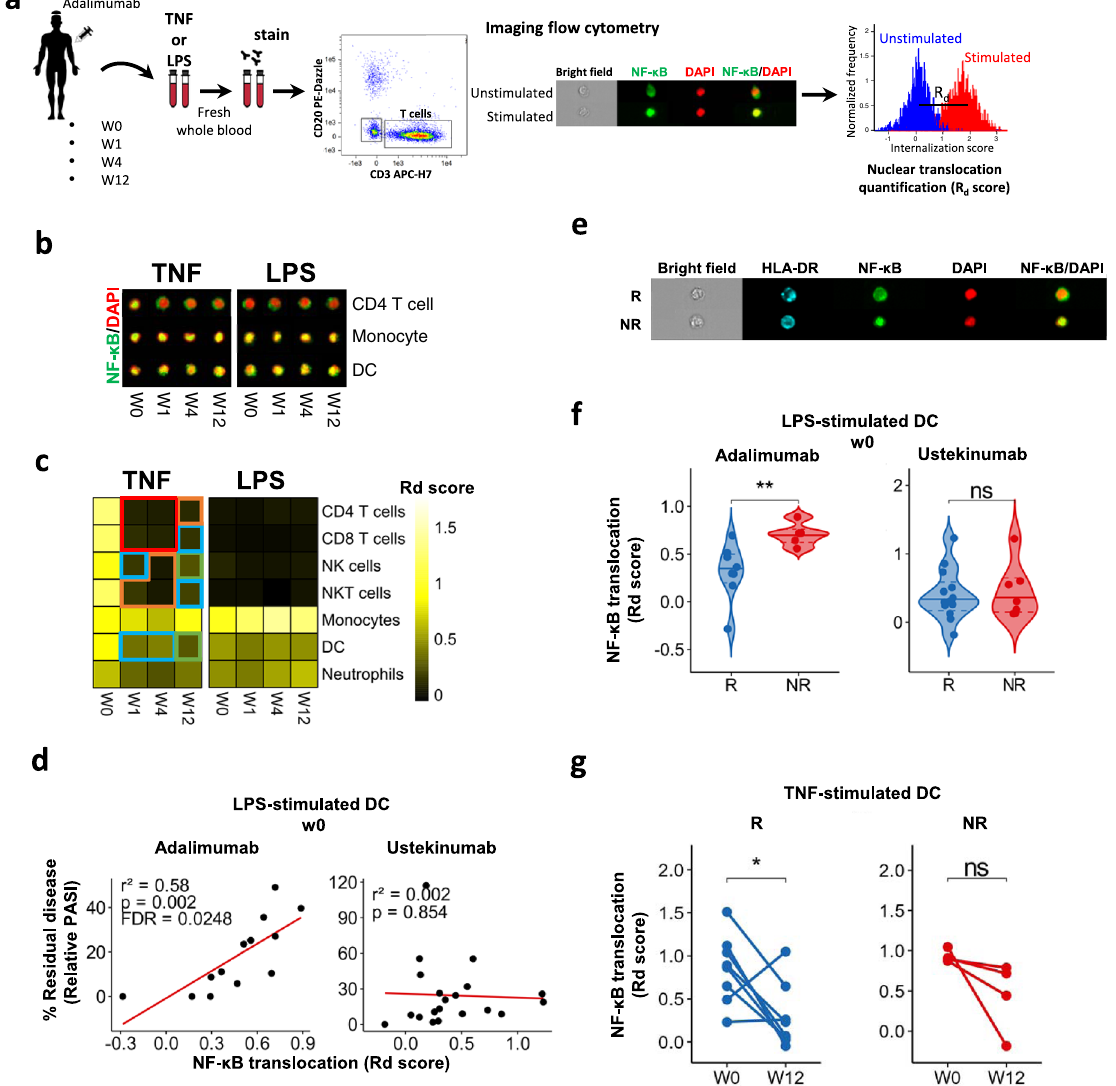
Fig. 1 LPS-induced NF- κ B translocation in DCs at baseline correlates with response to adalimumab. a Cartoon depicting the experimental work fl ow. Whole blood from psoriasis patients collected at baseline (week0, w0) and at w1, w4 and w12 after initiation of adalimumab therapy was stimulated with TNF, LPS or left unstimulated, stained with fl uorescent antibodies and NF- κ B nuclear translocation was measured in distinct cell populations identi fi ed by imaging fl ow cytometry, as shown in the representative images included in the cartoon. b Representative fl uorescent images of selected cell populations stained for NF- κ B (green) and nucleus (DAPI, red); their colocalization is shown in yellow. c Heatmap showing NF- κ B nuclear translocation measured as Rd score in immune cell populations ( n = 13 – 16). d Correlation analysis between NF- κ B translocation (measured as Rd score) at w0 and clinical response expressed as percentage of residual disease at w12 (measured as relative PASI, i.e. PASI at w12/PASI at w0 X 100) in LPS-stimulated dendritic cells (DCs) in PSORT adalimumab ( n = 13) and ustekinumab cohort ( n = 24). Each dot represents one patient. e Representative fl uorescent image of LPS-stimulated DCs at w0 from PASI75 adalimumab responder (R) and non-responder (NR). f Violin plot graphs of NF- κ B translocation in LPS-stimulated DCs at w0 for PASI75 adalimumab and ustekinumab responders (blue, adalimumab = 8; ustekinumab = 13) and non-responders (red, adalimumab = 5; ustekinumab = 7) ** p = 0.0062. g NF- κ B translocation in TNF-stimulated DCs at w0 and w12 in adalimumab PASI75 responders ( n = 8) and non- responders ( n = 4). Red frame: FDR < 0.0001, orange frame: FDR < 0.001, blue frame: FDR < 0.01, green frame: FDR < 0.05 compared to week (w) 0, test. * p = 0.039, Wilcoxon test followed by FDR ( c ), Wilcoxon ( g ) or Mann – Whitney U test ( f ). All tests are two-sided. Source data are provided as a Source Data fi NF- κ B translocation in DCs at baseline correlates with lack of NF- κ B translocation in psoriasis patients (Fig. 1b, c; Supple- response to adalimumab . Next, we investigated whether NF- κ B mentary Fig. 3c and Supplementary Data 2). Thus, we concluded that the free adalimumab present in the blood stream of patients nuclear translocation, induced by TNF or LPS, correlated with undergoing therapy completely blocks NF- κ B signalling in T, NK clinical response to adalimumab. Response was assessed applying and NKT cells but only partially in DC, raising the possibility that either a continuous model, where the outcome is % residual the incomplete inhibition observed in DC may affect clinical disease at week 12 measured by relative PASI (i.e. PASI at week outcome. 12 divided by PASI at w0 × 100), or a binary model, using gold